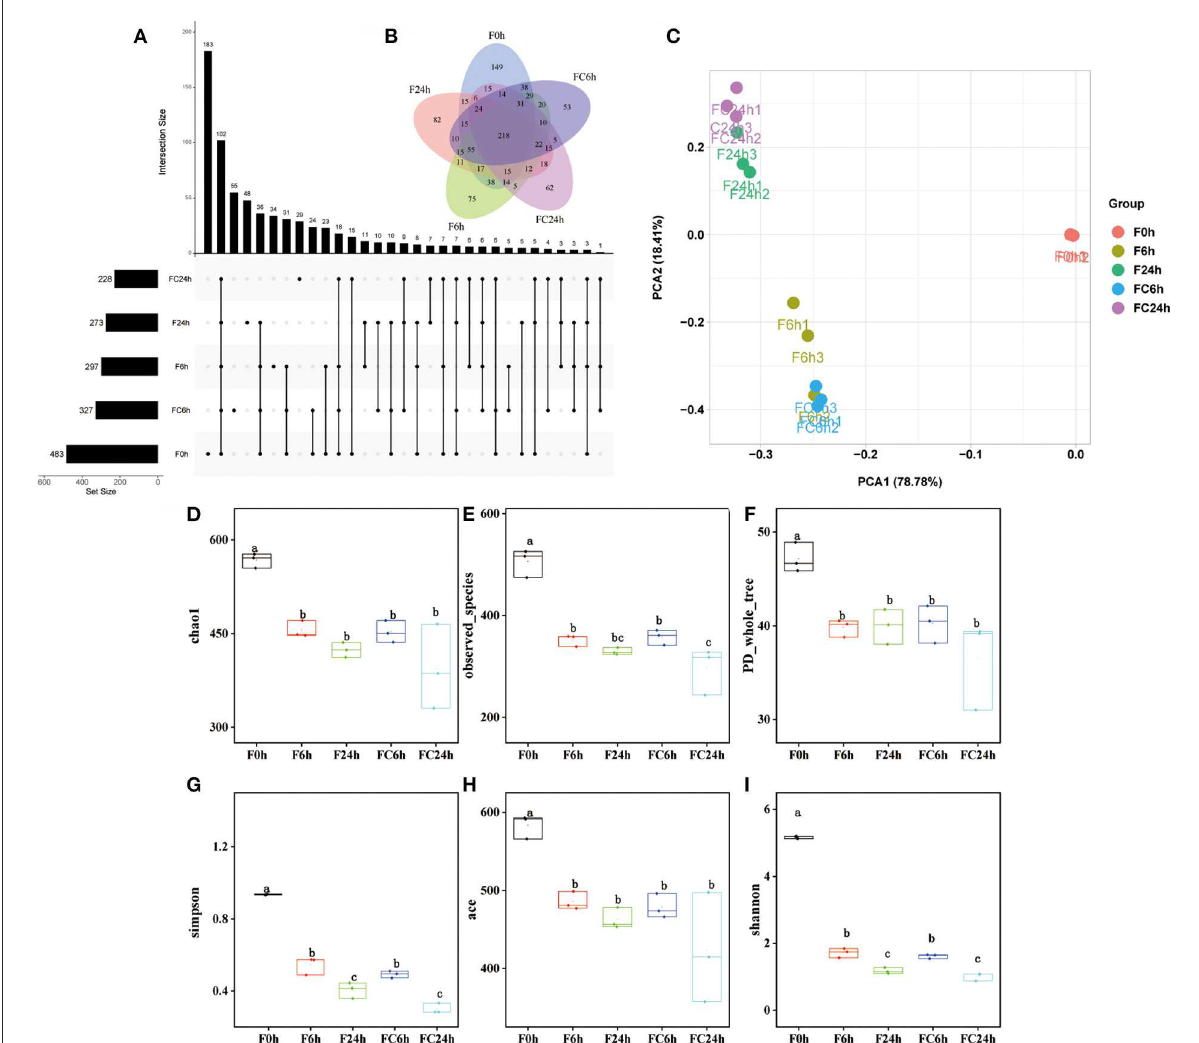
FIGURE8 Alpha diversity indices boxplot among groups. (A) Upset plot; (B) Venn diagram; (C) PCA analysis; (D) Chao index; (E) Observed species; (F) PD whole tree; (G) Simpson index; (H) ACE index; (I) Shannon index; F0h = Fermentation for 0h with FJR; F6h = Fermentation for 6h with FJR; F24h = Fermentation for 24h with FJR; FC6h = Fermentation for 6h without FJR; FC24h = Fermentation for 24h without FJR. Different letters (a–c) mean significant difference ( p <